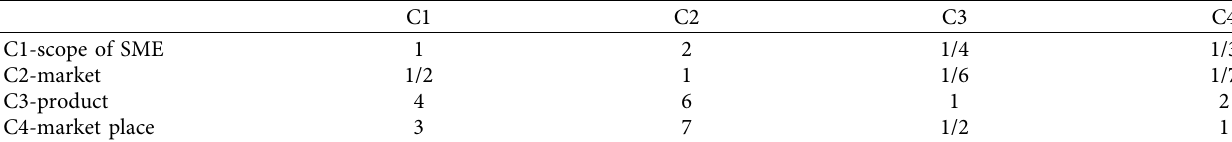
Table 4: Comparison of priorities between criteria with TFN scale.